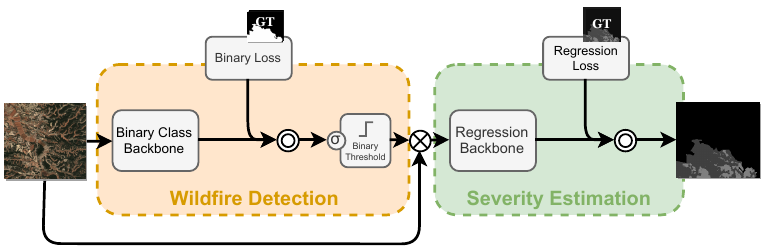
Figure 1. Double-Step deep learning Framework